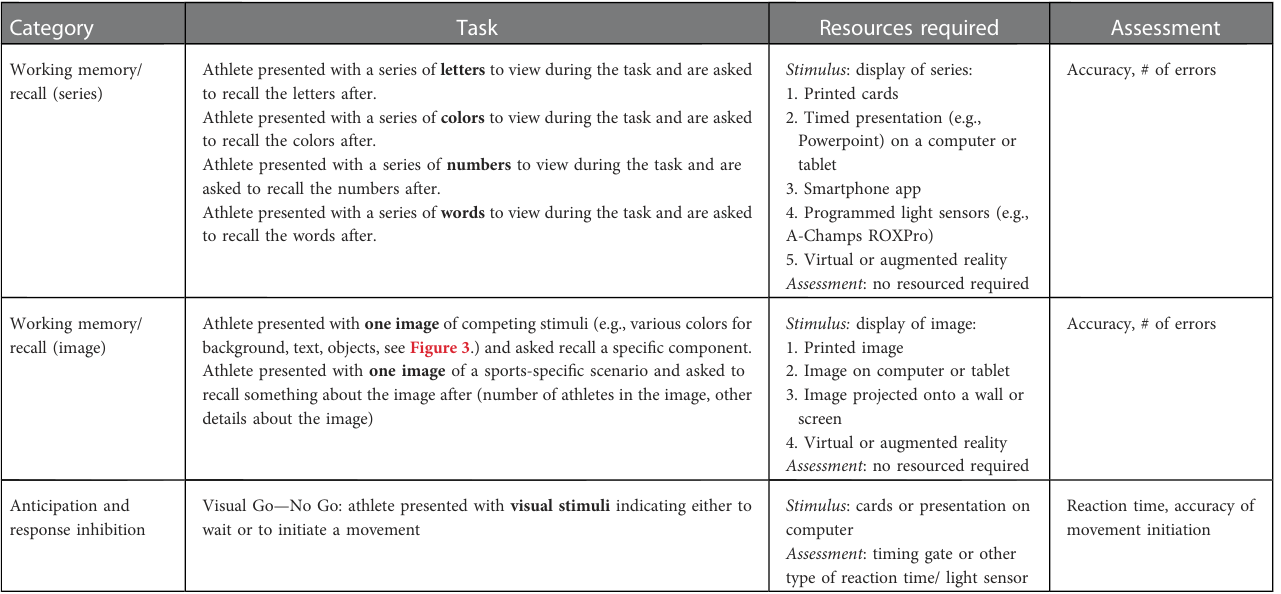
TABLE 1 Suggested cognitive tasks that are measurable and can be added to current functional performance tests.